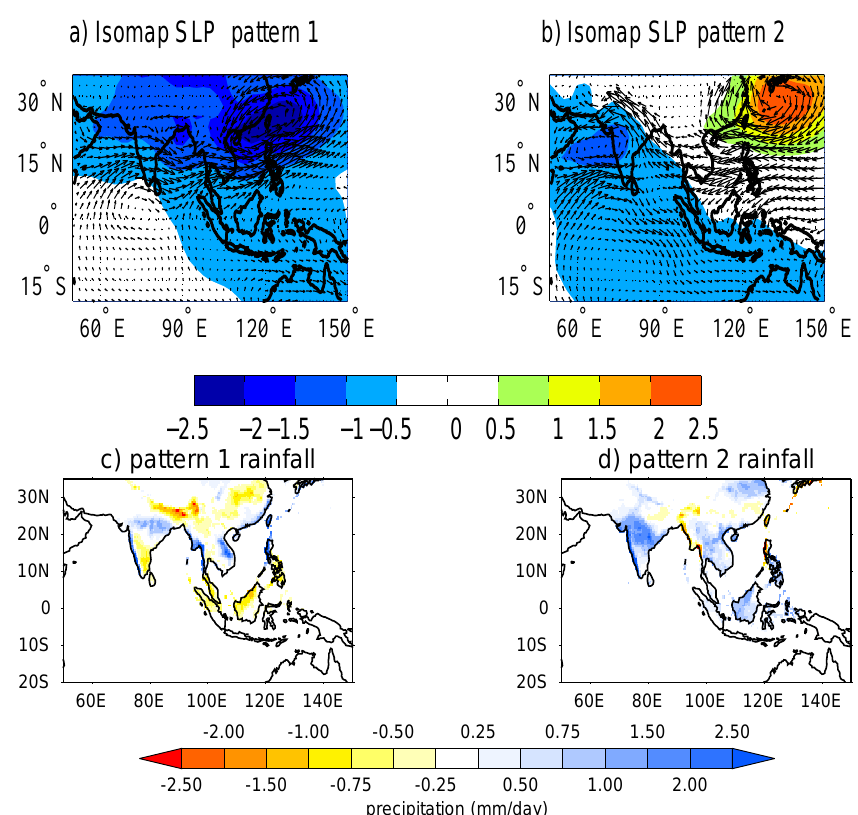
Fig. 7. Regression onto the first (a) and the second (b) Isomap time series of the SLP and 850hPa wind anomalies. Units: hPa for SLP and maximum wind speed is 2.5ms − 1 . Regressions for APHRODITE daily precipitation are also shown in (c) and (d)